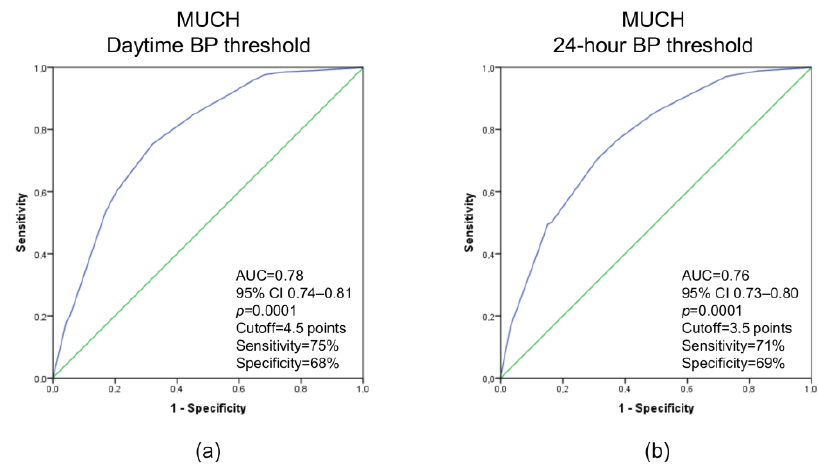
Figure 2. Receiver operating characteristic curves based on the score systems in predicting masked uncontrolled hypertension (MUCH) defined by daytime blood pressure (BP) threshold ( a ), regardless of nighttime BP, and by 24 h BP threshold ( b ), regardless of daytime or nighttime BP. For MUCH defined by daytime BP threshold, the score is as follows: clinic systolic BP 130–139 mmHg = 3 points; clinic diastolic BP 85–89 mmHg = 1.5 points; men = 1 point; smoker = 1 point; left ventricular (LV) hypertrophy = 1 point. For MUCH defined by 24 h BP threshold, the score is as follows: clinic systolic BP 130–139 mmHg = 1.5 points; clinic diastolic BP 85–89 mmHg = 2 points; men = 1 point; smoker = 1 point; LV hypertrophy = 1 point. Other abbreviations: AUC, area under the curve; CI, confidence interval.